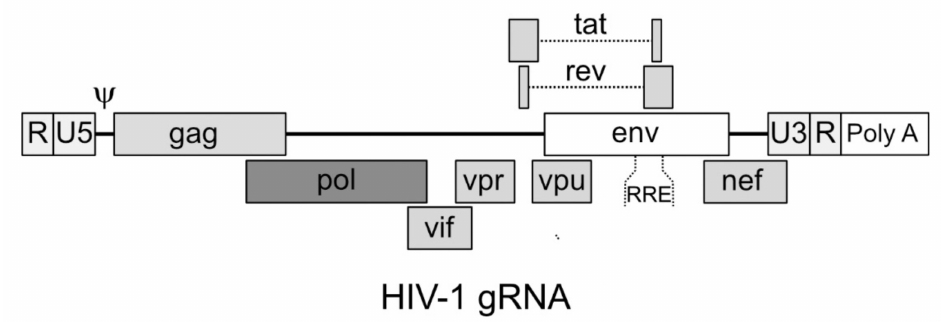
Figure 1. Organization of the human immunodeficiency virus type 1 (HIV-1) genomic RNA. U3, unique sequence 3’; R, repeated sequence; U5, unique sequence 5’; Ψ , indicates the packaging and dimerization sequences; RRE, Rev responsive element. The PPT sequences as well as the primer binding sequence (PBS) region are not